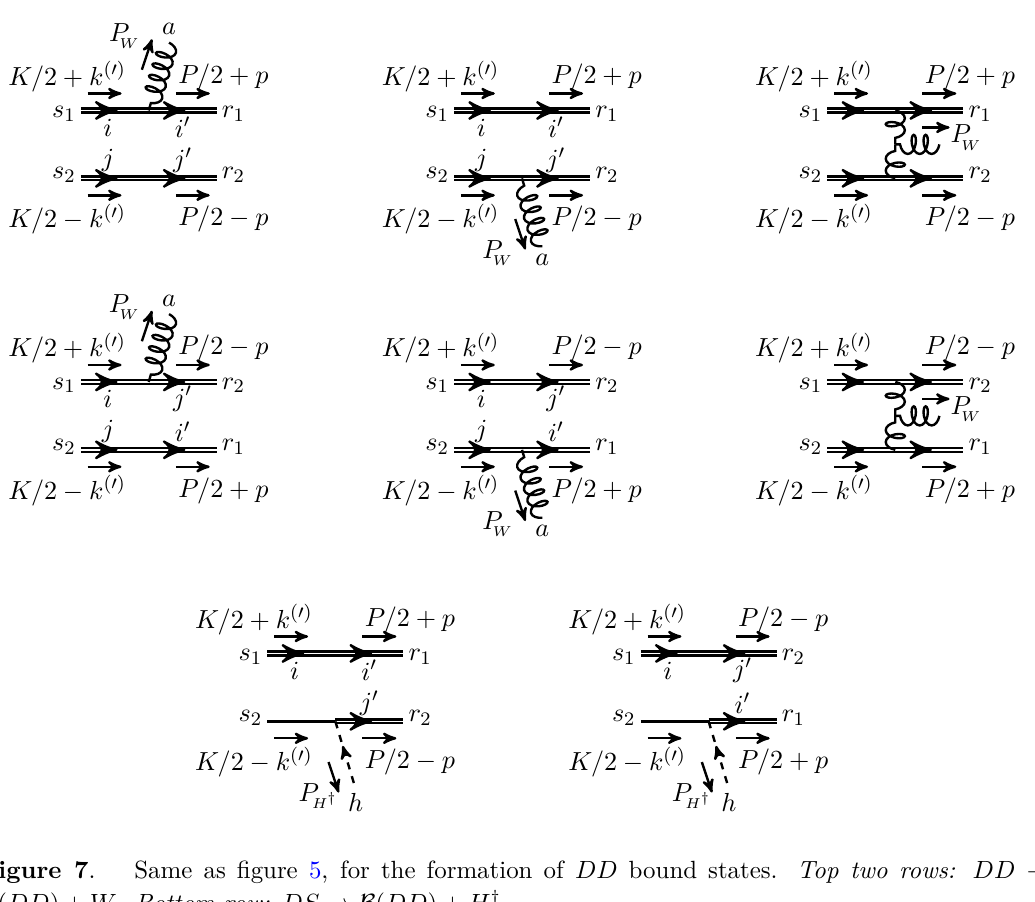
(cid:3) / 4 . All processes have conjugate counterparts. rel